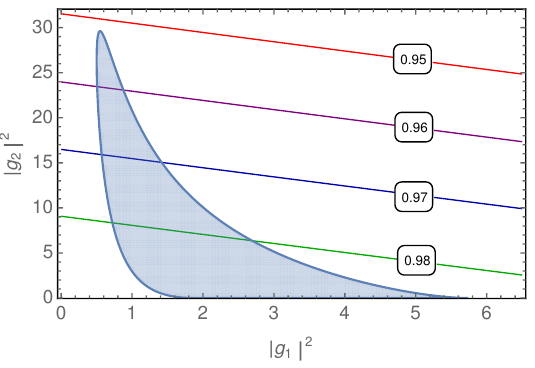
Figure 1. U (cid:22) (cid:24) (3 ; 1) couplings at 95% C.L. for M U = 1 TeV. Colored lines are contours 2 = 3 of R (cid:7)(1 S ) . (cid:28)=‘